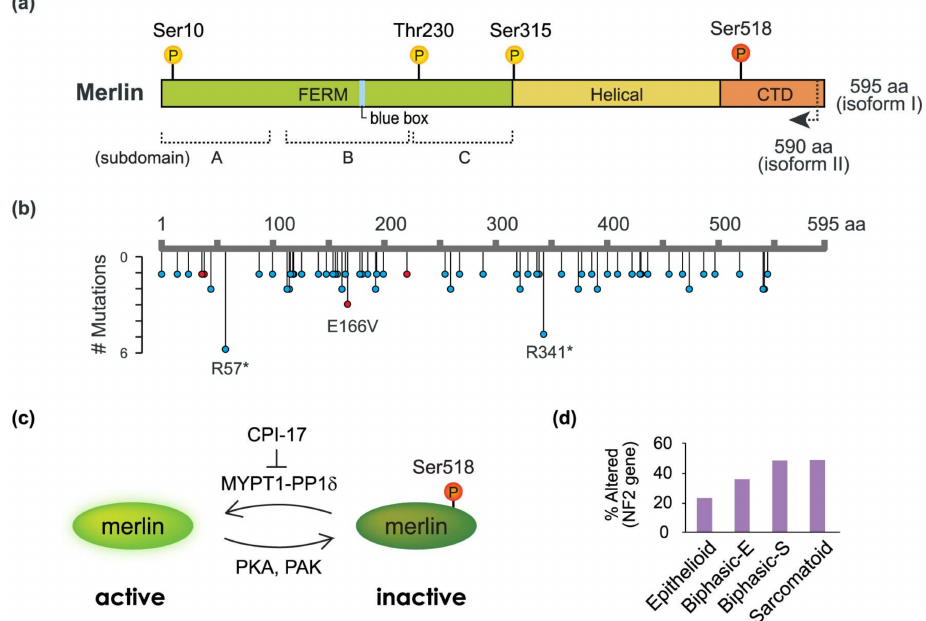
Figure 1. Mechanisms underlying the activation/inactivation of merlin. ( a ) Domain organization of merlin. The protein consists of the N-terminal FERM (band 4.1/ezrin/radixin/moesin) domain (green) comprising three subdomains (A, B, and C), a central helical domain (yellow), and a C-terminal domain (CTD, orange). Major phosphorylation sites are indicated; ( b ) NF2 mutations and their frequency in pleural and peritoneal cancers. Nonsense/frameshift (blue) and missense (red) mutations registered in COSMIC (Catalogue of Somatic Mutations in Cancer; http://cancer.sanger.ac.uk/cosmic/) as of 27 February 2018, are mapped; ( c ) Phosphorylation-dependent inactivation of merlin. Phosphorylation at Ser518 inactivates merlin and inhibits its growth suppression activity; ( d ) Frequency of genetic alterations in the NF2 gene, including mutations, fusions, and copy number variations in different subtypes of malignant pleural mesothelioma based on an analysis of 211 malignant plural mesothelioma samples. The data were adapted from Bueno et al.